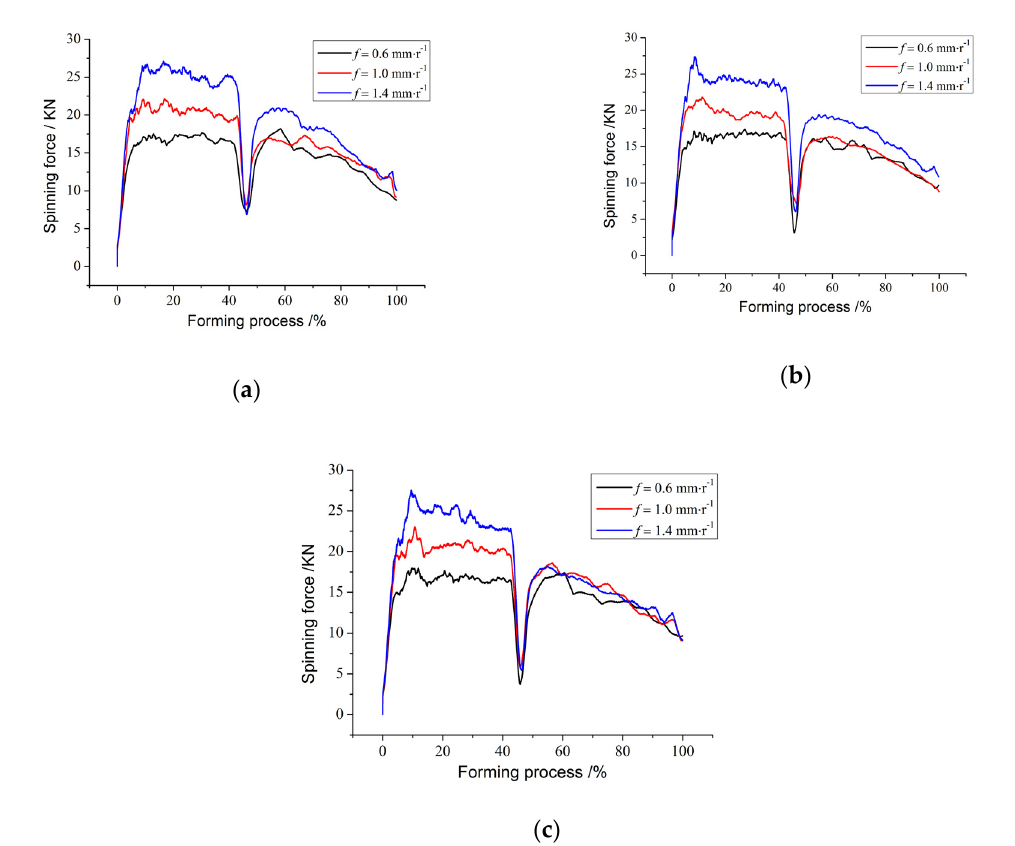
Figure 9. The change of the spinning force when ω is the same: ( a ) ω = 200 r/min; ( b ) ω = 320 r/min; and ( c ) ω = 450 r/min.